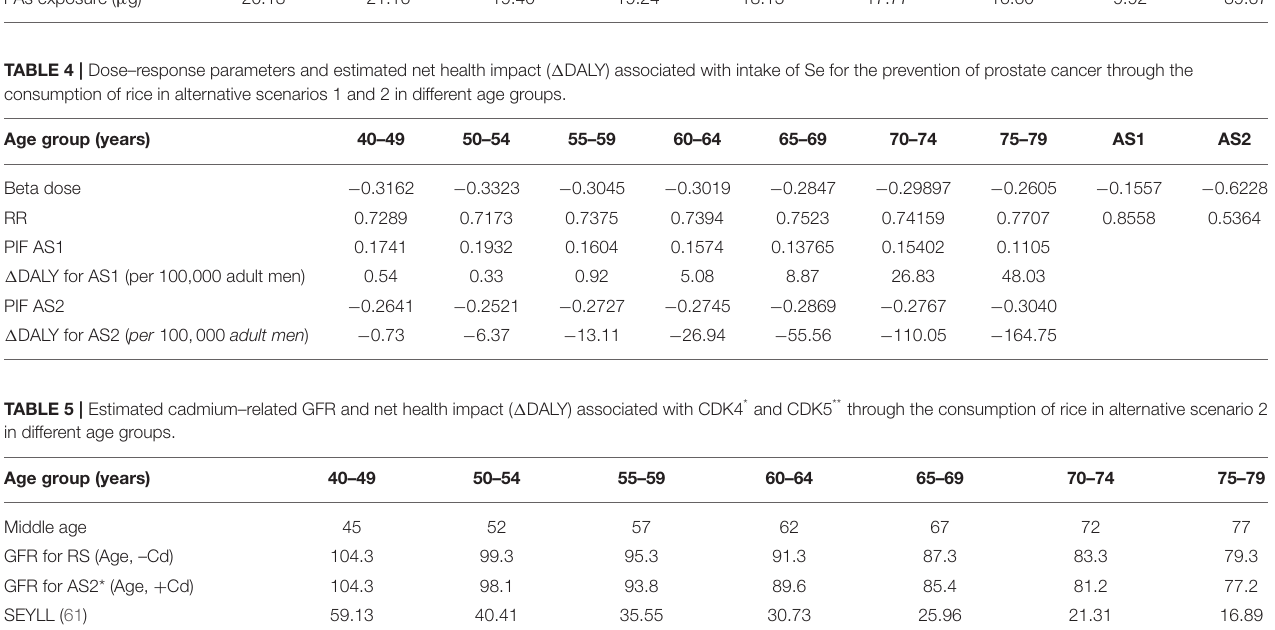
skin cancer were calculated using the DisMod II software and WHO disease Burden Excel template (62), combined with the number of cases of three cancers in China in